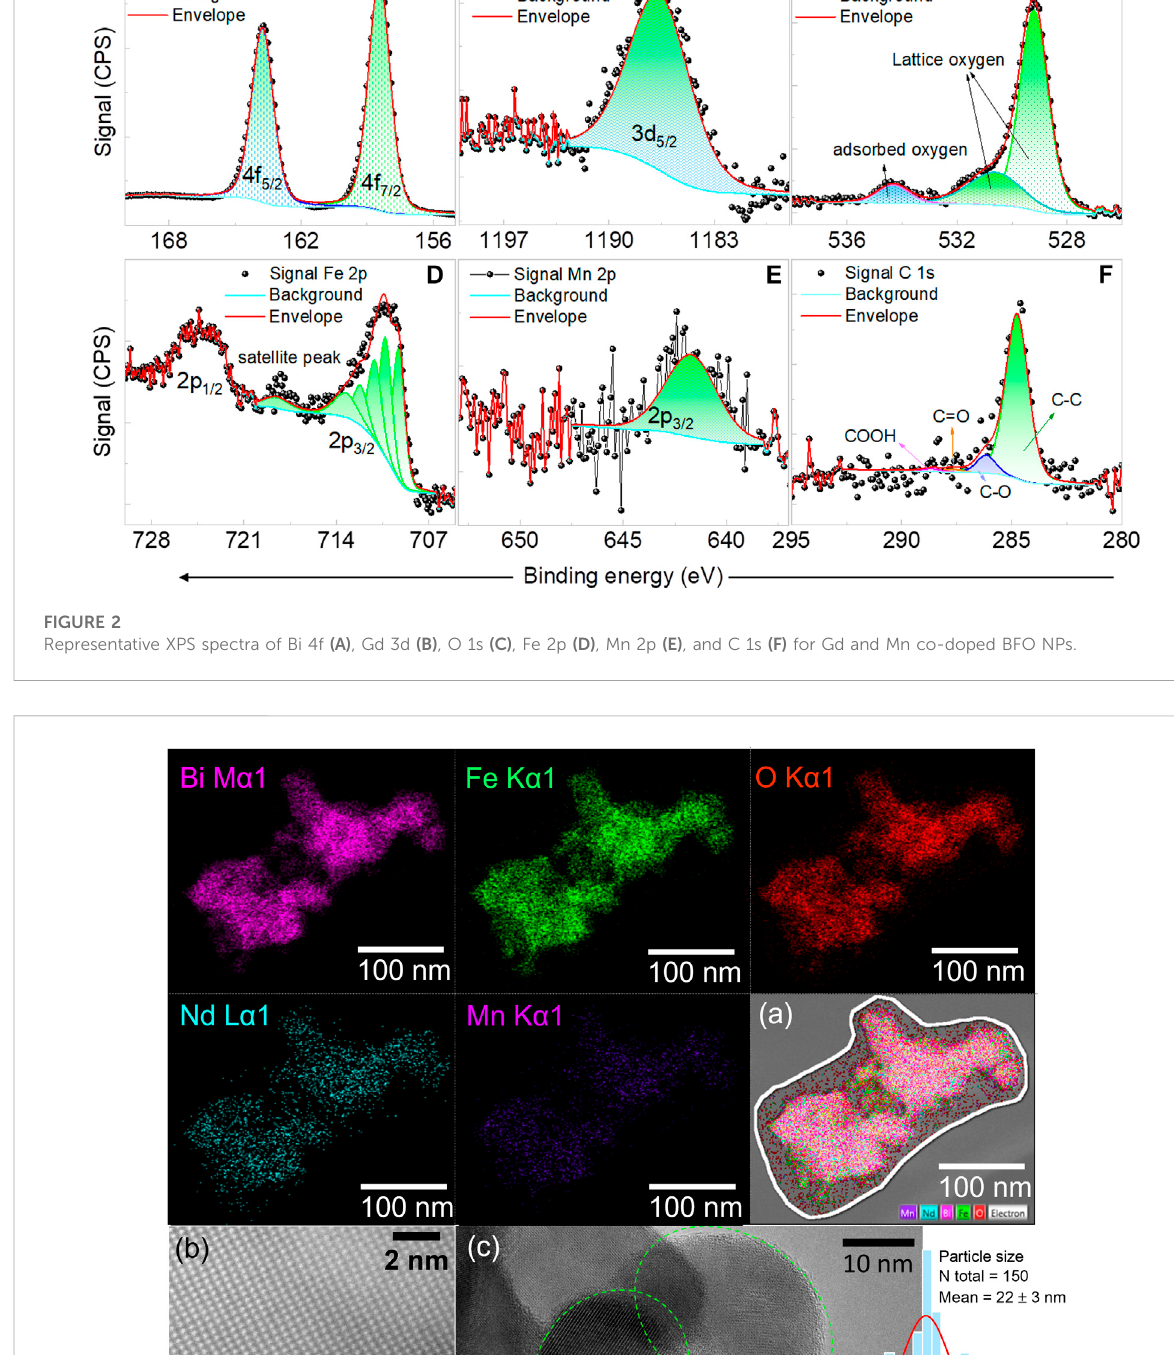
Frontiers in Bioengineering and